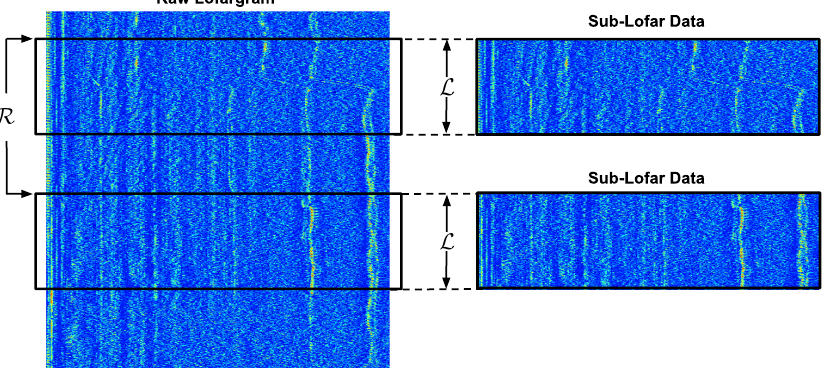
Figure 4. An overview of the sub-imaging process. For each LOFARGRAM, sub-images of size L × 400 were taken at every R rows.